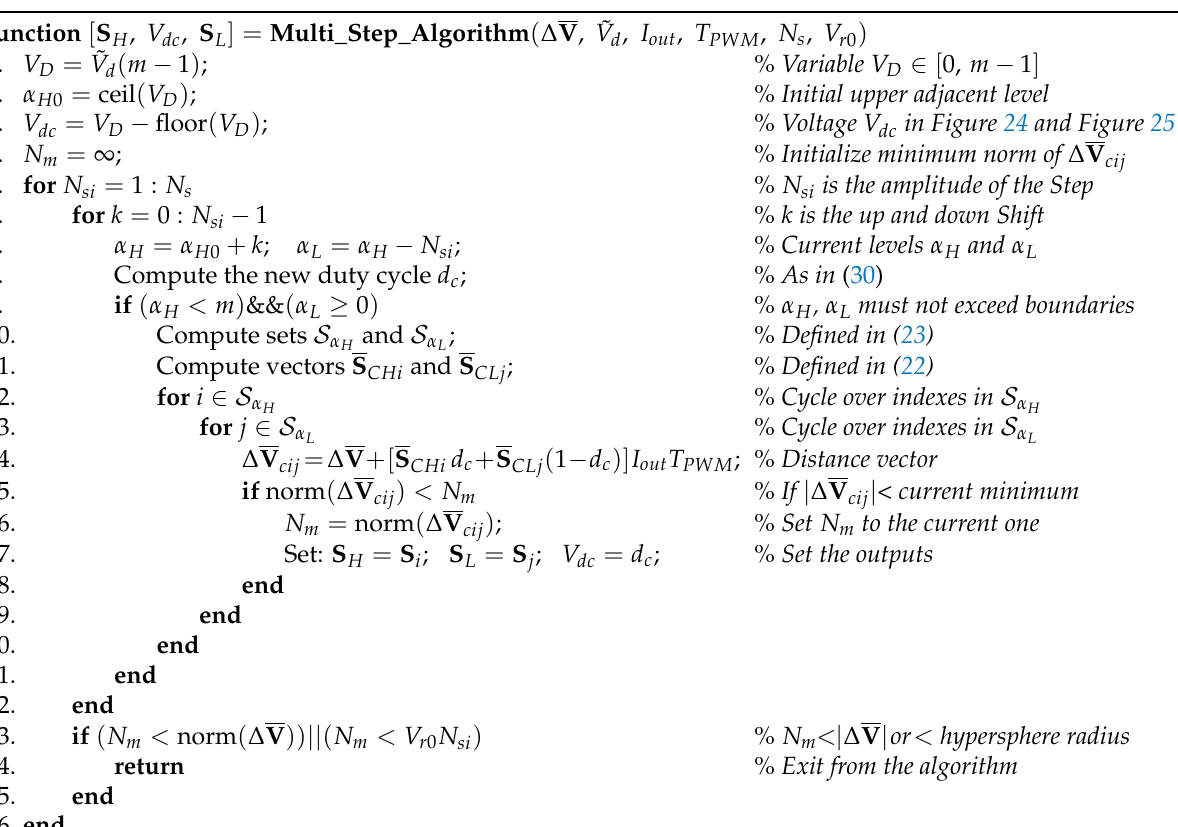
and S j associated with the higher and lower level H L and S associated with the j H j L and T . T H H PWM −